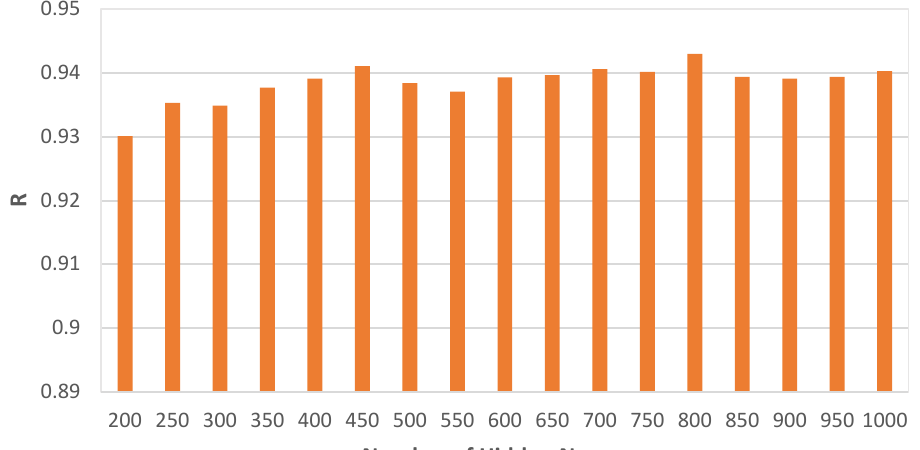
Figure 6. Average Pearson correlation coefficient (R) values of the RELM method with different network